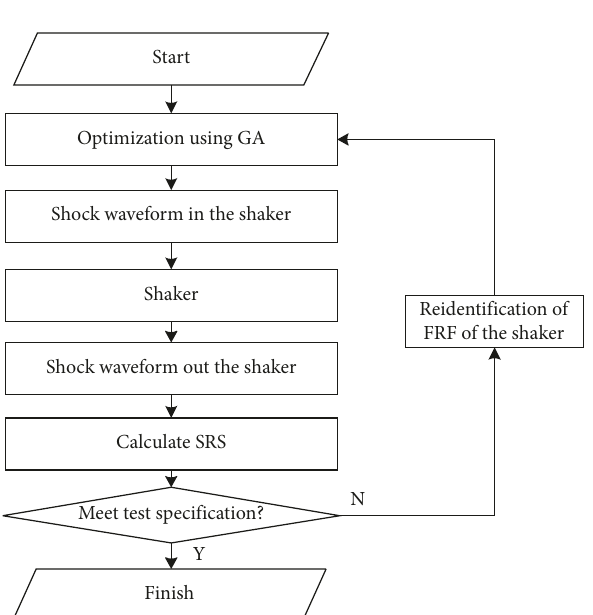
Figure 9: Impulse response spectrum time-domain matching